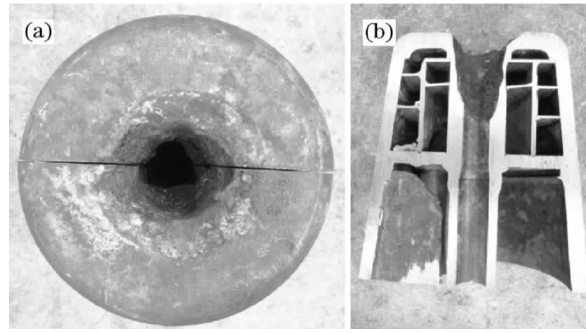
Figure 10: Schematic diagram of chambering in the front of tuyere: (a) before dissecting, (b) after